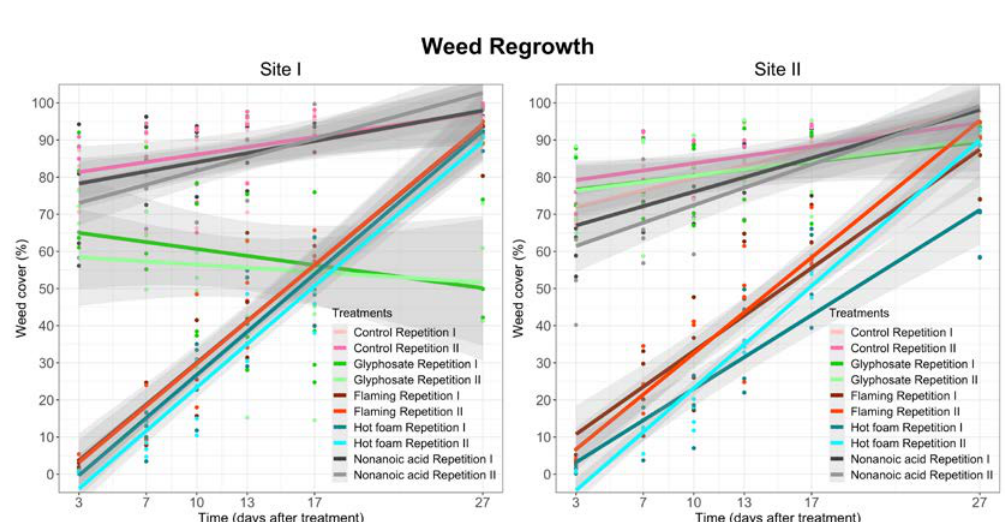
Figure 4. Regression lines with all the points and 95% confidence interval bands of percentage weed cover as affected by the treatments (control, flaming, glyphosate, hot foam and nonanoic acid), the repetition ( I , II ) and the evaluation date (time) in the two sites. ( Site I ) residual standard error = 0.123; multiple R-squared = 0.859; adjusted R-squared = 0.846. ( Site II ) residual standard error = 0.089; multiple R-squared = 0.916; adjusted R-squared = 0.909.